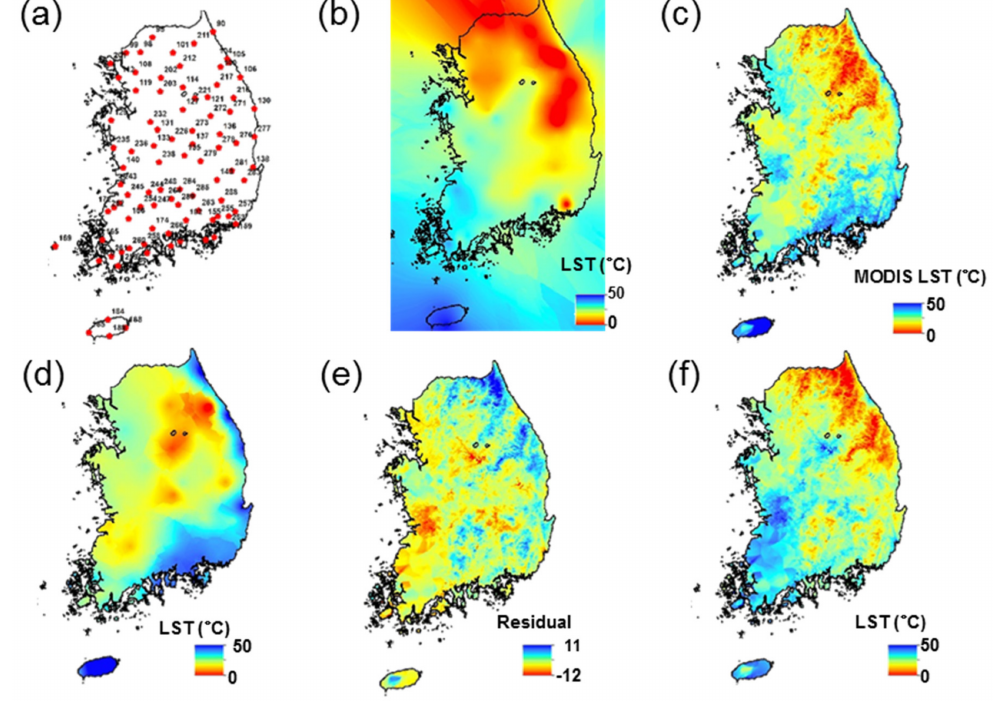
Figure 3. Conditional merging process for MODIS LST: ( a ) Observed LST are collected at 71 stations of KMA; ( b ) LST values measured at the 71 stations are interpolated using the ordinary kriging technique; ( c ) Satellite LST data; ( d ) Satellite LST at the 71 gauging stations are extracted and then spatially interpolated using the ordinary kriging technique; ( e ) Residual between ( c ) and ( d ); ( f ) Residual values of ( e ) added to the data from ( b